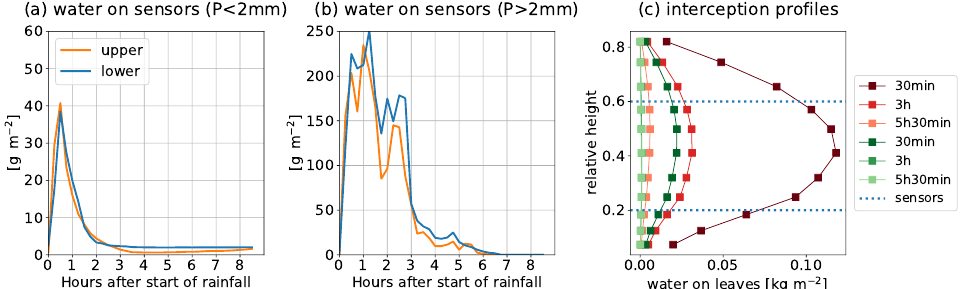
Figure 6. Vertical distribution of rainfall interception, with the averaged mass of water detected on upper and lower sensors [g m − 2 ] during: ( a ) 6 light rain events (P < 2 mm); and ( b ) 4 heavy rain events (P > 2 mm) in the period between 1 June and 13 June; and ( c ) the resulting vertical interception profiles changing during light (green) and heavy (red) rain events, including relative heights of sensors. Note that the data are aggregated. Nocturnal rain events tend to lead to longer periods of canopy wetness, while rainfall interception during the day tends to evaporate rapidly.